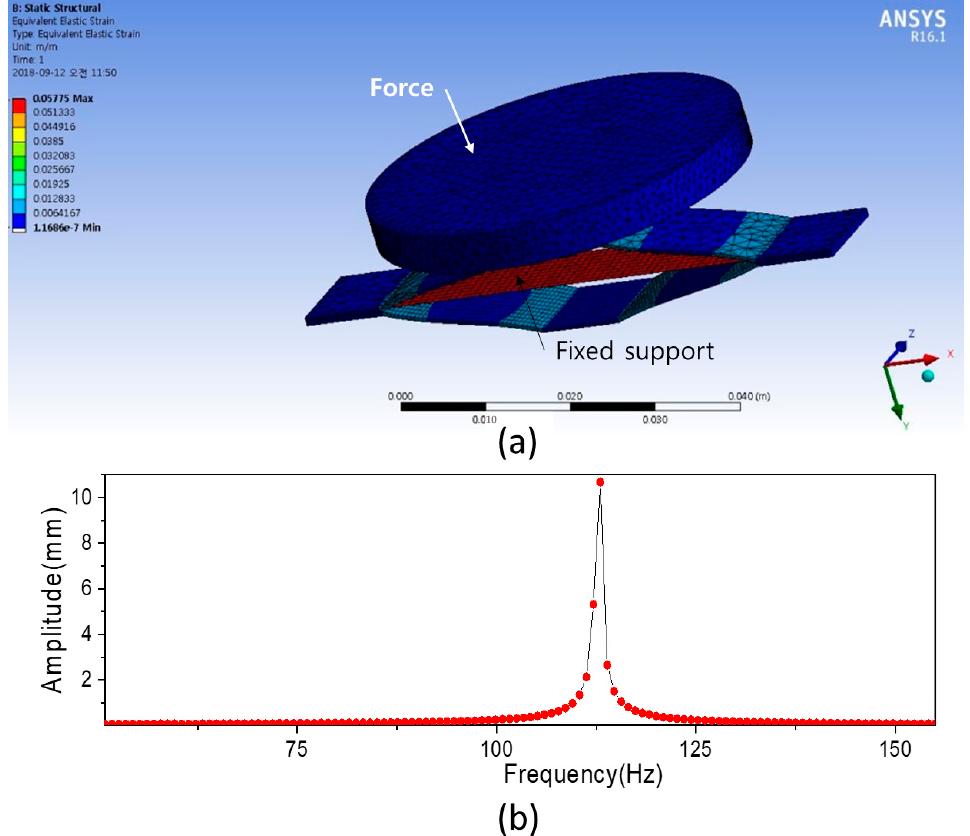
Figure 9. ( a ) FEM mesh model of VEH; ( b ) harmonic analysis result.